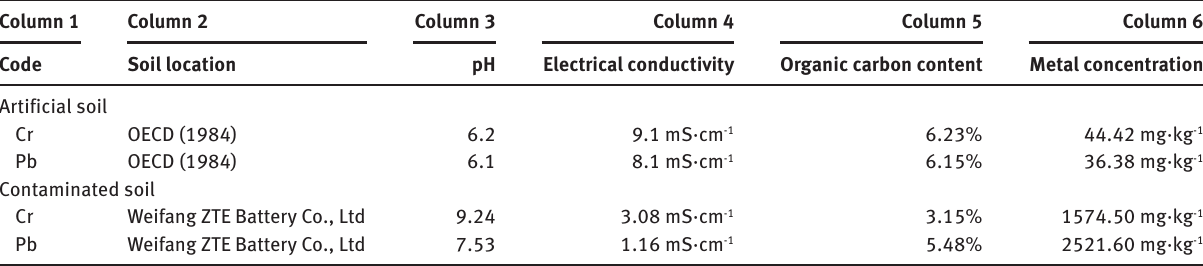
Table 1: Soil sample characteristics. Column